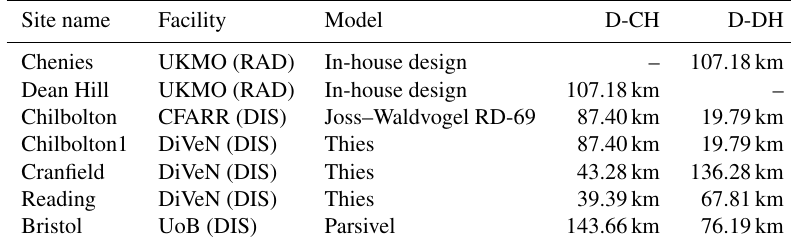
Table 2. Summary of radars (RAD) and disdrometers